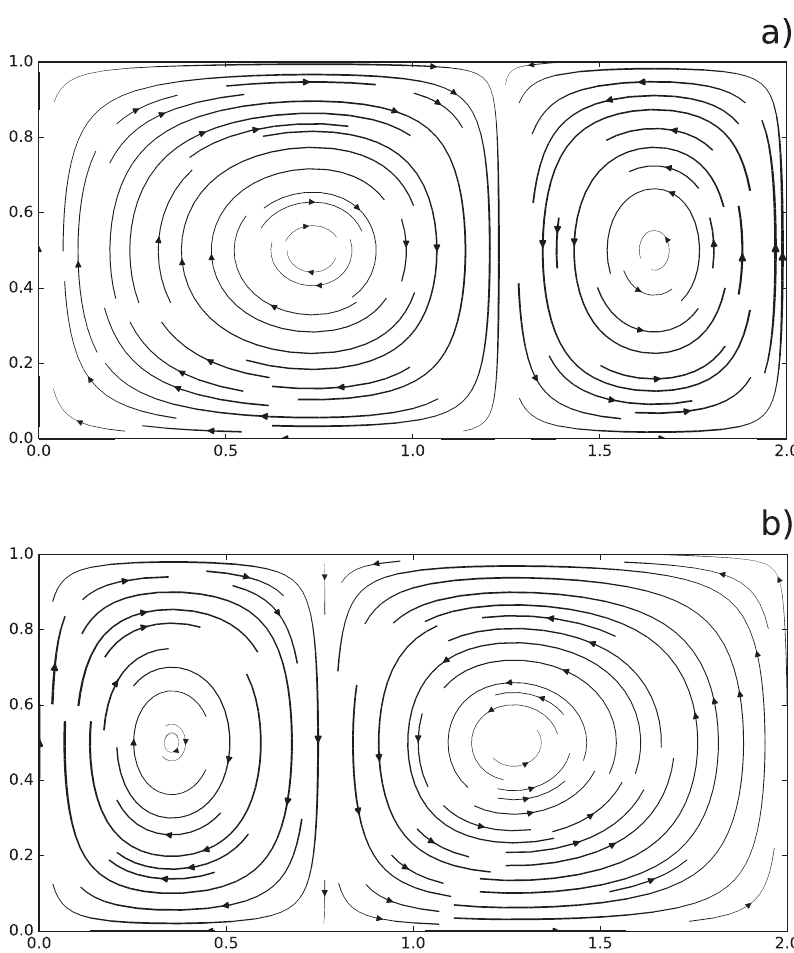
Fig. 3 Streamlines of the double-gyre fl ow. Plots of streamlines for t = 2.5 ( a ) and t = 7.5 ( b ), thicker lines are associated to higher velocities. The circulation is dominated by two gyres rotating in opposite directions separated by a vertical boundary that oscillate periodically along the horizontal direction. This time-dependence generates chaotic trajectories that induce complex mixing patterns across the entire fl ow domain.